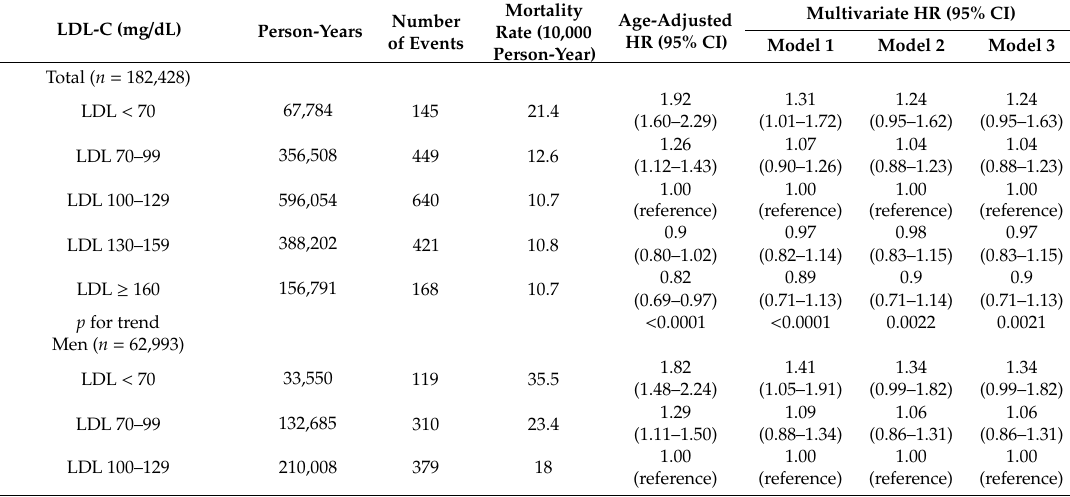
Table 7. Risk of cancer mortality according to baseline LDL-C levels excluding subjects who died within 3 years of follow up in KoGES